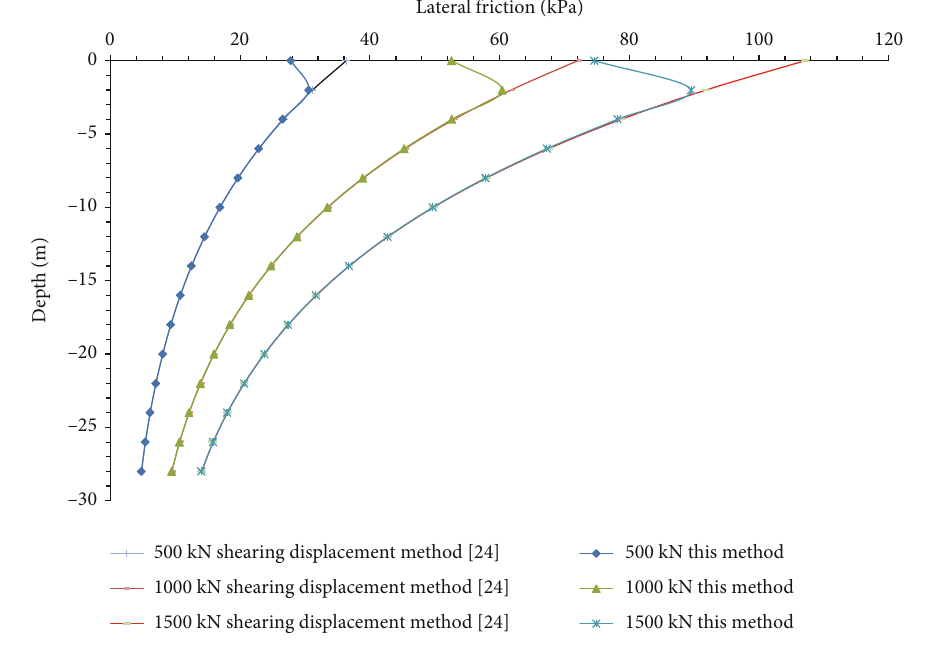
Figure 6: Comparison of lateral friction along pile length of T4. Table 3: Calculation